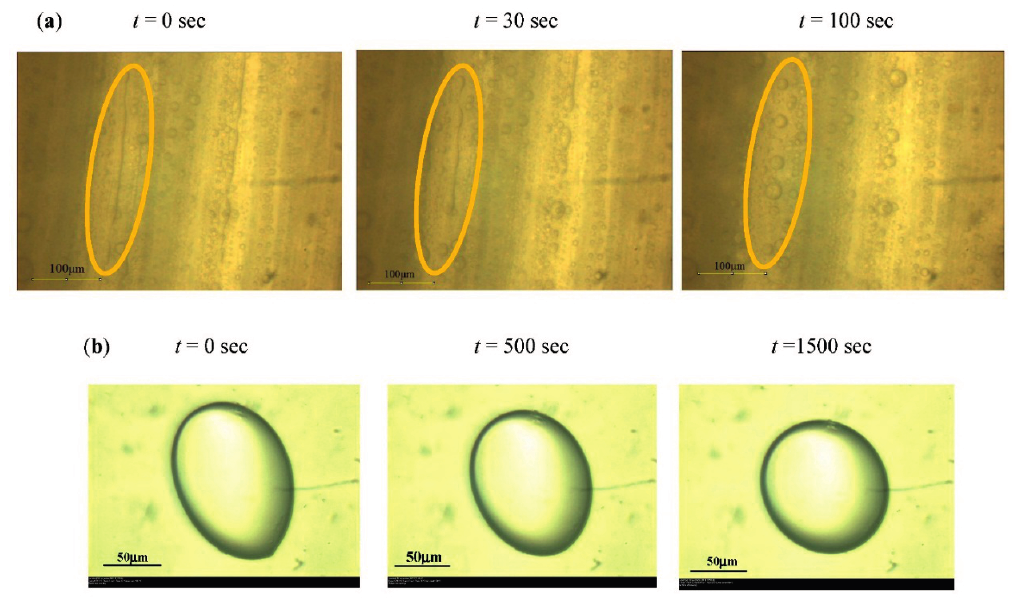
Figure 4. Examples of illustrations of the ellipsoid drop retraction, immersed in a fluid matrix at 180 °C of ( a ) uncompatibilized and ( b ) compatibilized PLA–PBAT blends. The measurement time (in second) is noted on each micrograph.